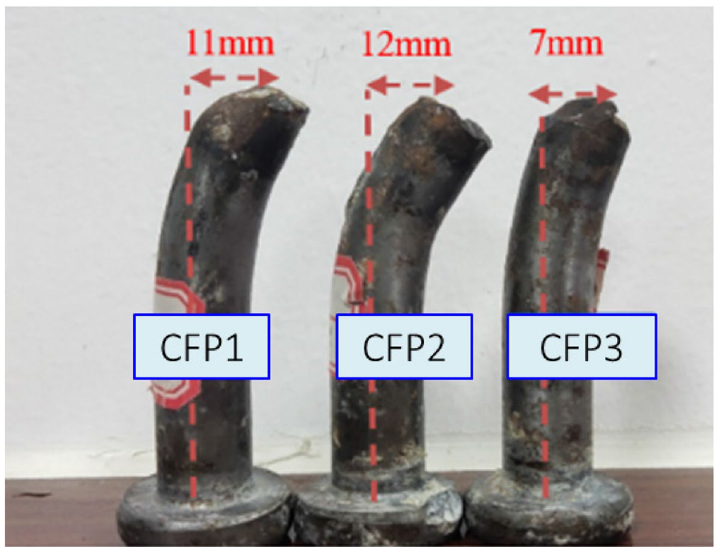
Fig. 10 Stud deformation